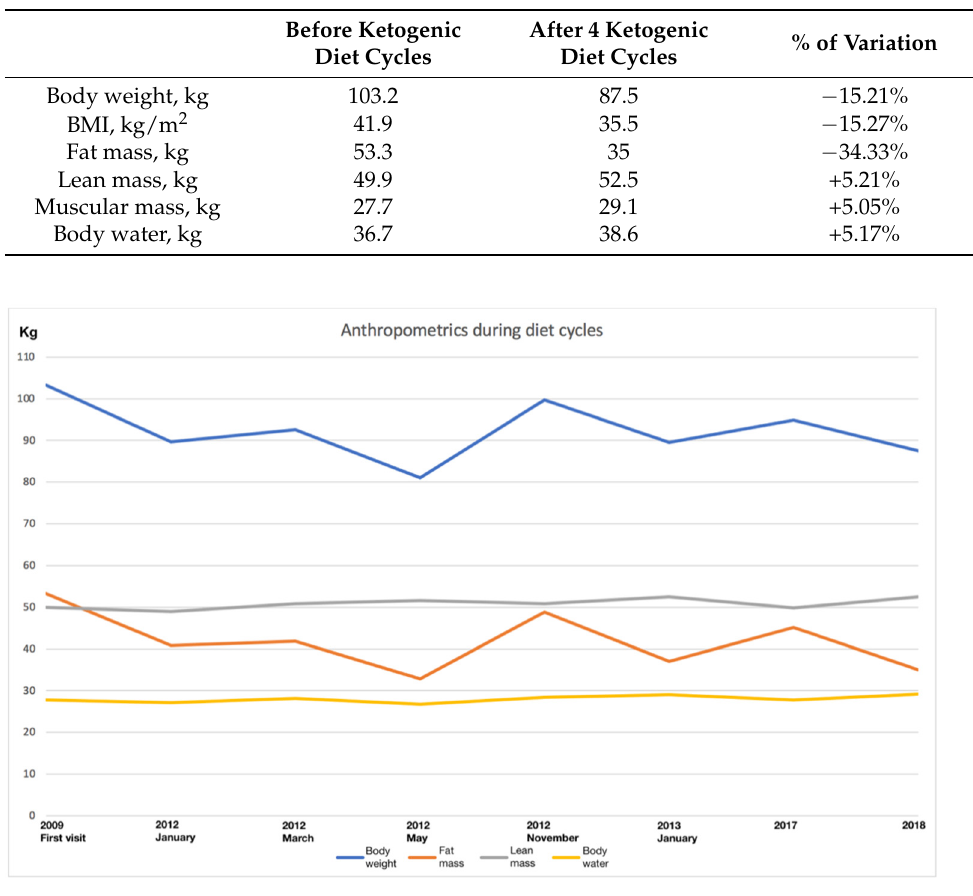
Table 3. Overall changes in terms of body weight, BMI, fat mass, lean mass, and muscle mass before and after ketogenic diet cycles.